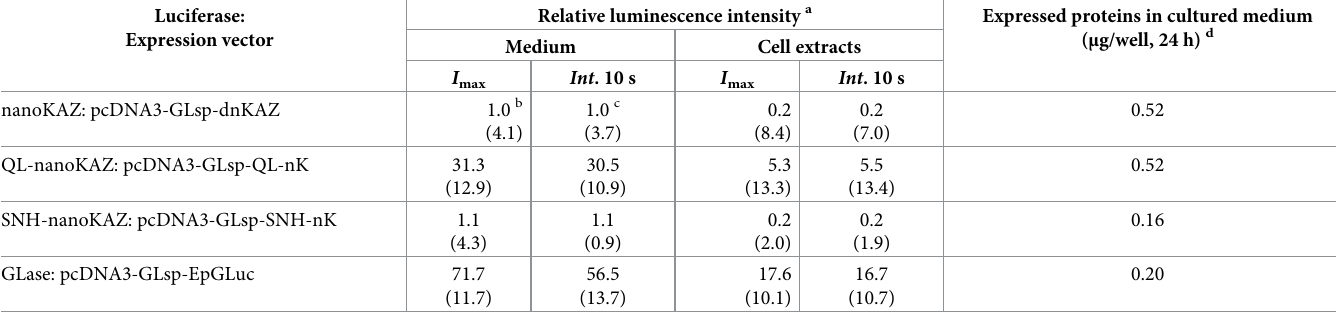
Table 4. Comparison of gene expression among nanoKAZ, QL-nanoKAZ, SNH-nanoKAZ, and GLase in CHO-K1 cells. Luciferase: Expression vector